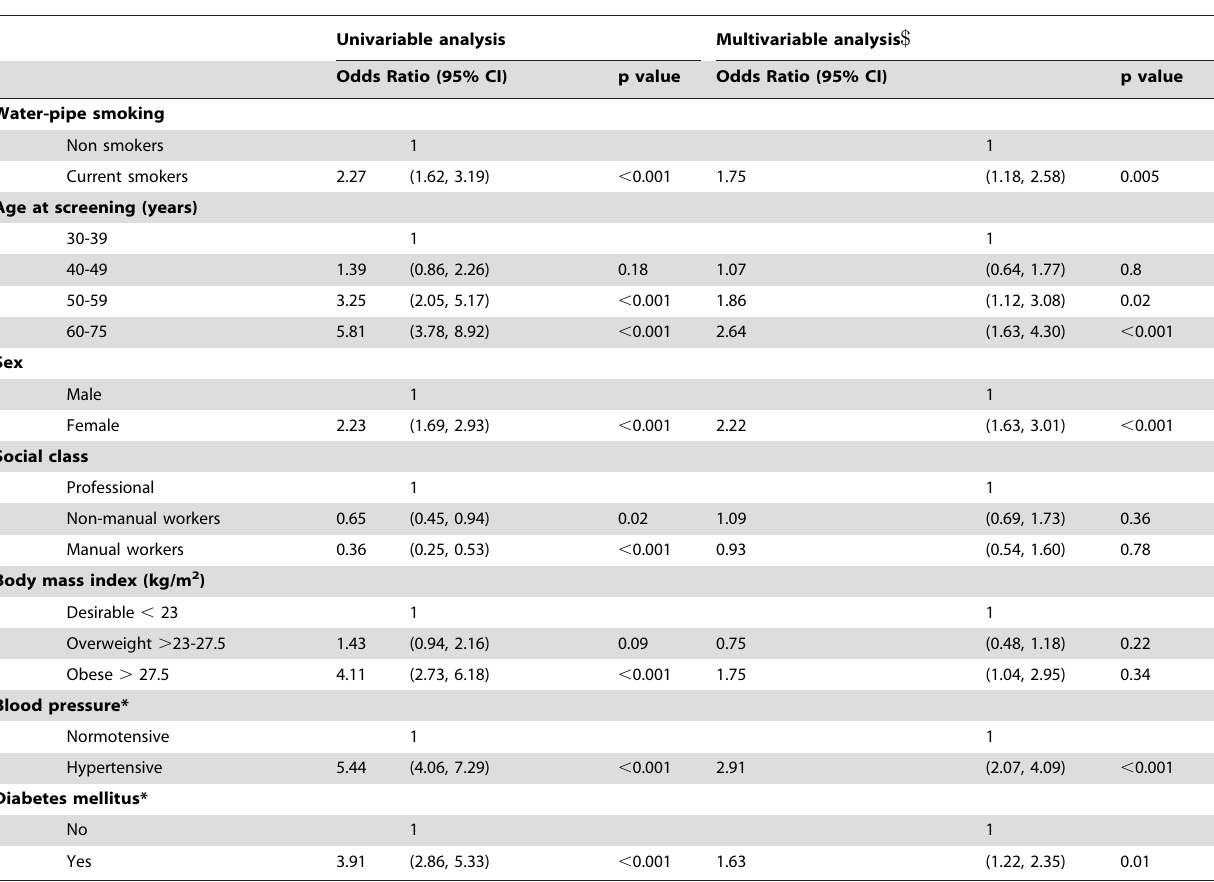
Table 3. Relationship between water-pipe smoking and